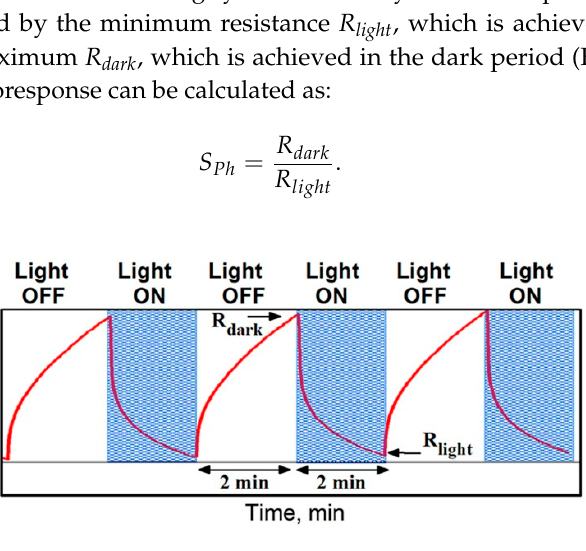
Figure 6. Absorption spectra of the pure semiconductor oxide (1), Ru-TT complex (2), hybrid sample (3) and spectral dependences of photoconductivity (4) of In 2 O 3 Ru-TT ( a ) and SnO 2 Ru-TT ( b ).